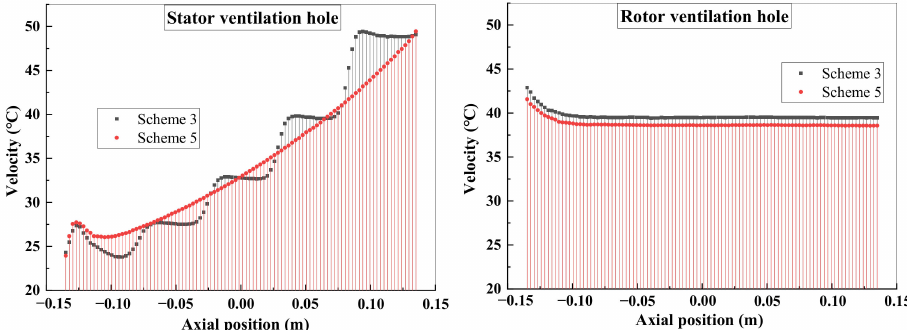
Figure 12. Velocity comparison of nonlinear variable cross-section and linear variable cross-section stator ventilation